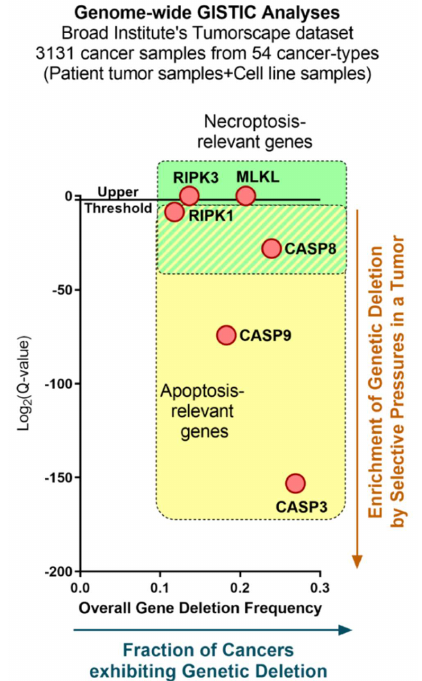
Figure 1. A genetic analysis of tumor-specific genetic “selection pressures” on apoptosis- and necroptosis-relevant genes. A Genomic Identification of Significant Targets in Cancer (GISTIC) analysis of DNA deletion based on the analysis of 3131 cancer samples from 54 cancer types using the Tumorscape (www.broadinstitute.org/tumourscape) database (accessed in May 2018). GISTIC scores ( X -axis) and false-discovery rate or FDR ( Y -axis; Q-values with 0.25 as cut-off for significance) for each alteration are plotted. GISTIC is an algorithm that strives to characterize putative cancer-driving somatic copy-number alterations (SCNAs) by analyzing the frequency as well as amplitude of the observed genetic events (e.g., deletions) [68]. Accordingly, GISTIC score ( X -axis) provides a prediction of genetic deletion events under both loci-specific selection pressure as well as background genetic (random) deletion rates (which naturally tend to be very high in cancer). However, the Q- values ( Y -axis) further allow the differentiation between the above two events, such that a significantly low Q-value signifies loci-specific selection pressures whereas a high Q-value signifies random genetic deletion events at the same rate as background genetic aberrations in cancer. For further details on this analysis’s methodology, we refer the reader to the publication by Mermel et al. [68]. Of note, whereas RIPK1 is indeed a necrosome-relevant gene, its functions are not exclusive to necroptosis since it can also play differential role in apoptosis or survival. Here, we will discuss the various aspects of necroptosis immunobiology focusing on immuno- oncology and cancer immunotherapy. While other forms of necrotic RCD such as ferroptosis (an iron- dependent RCD characterized by accumulation of lipid peroxides) and pyroptosis (a RCD dependent on caspases/granzymes-based, context-dependent, proteolytic activation of pore-forming gasdermin proteins, predominantly triggered by pathogenic stimuli) can elicit reactions in a tumor context; yet,